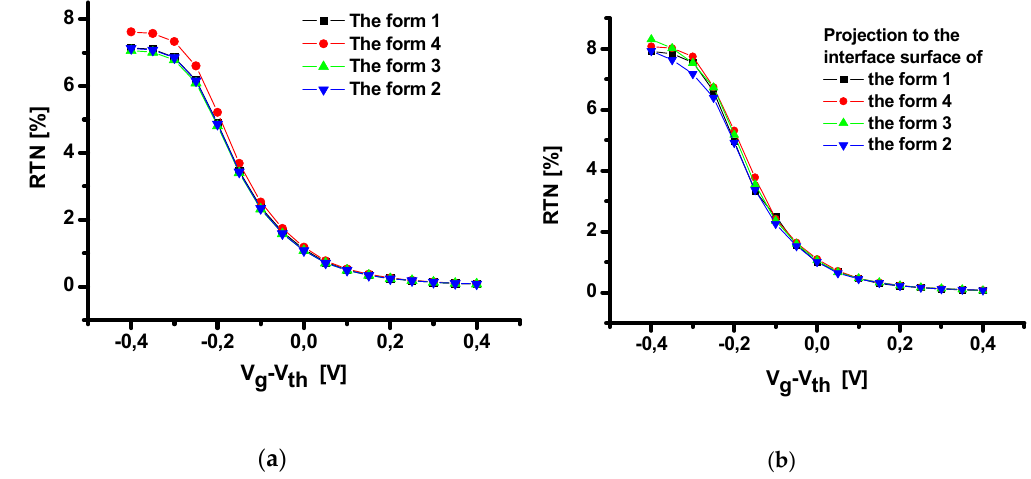
Figure 6. Random telegraph noise (RTN) amplitude dependence on the gate voltage overload generated by single charged defect with different forms: in the oxide layer ( a ) and at the interface ( b ). The RTN amplitude dependence on the radius of spherical or circular area of defects in the oxide or at the interface, correspondingly, was simulated to study the influence of the defect size. One has considered the radius range between 0.1 and 0.5 nm, which covers practically all featured linear sizes of atomic radius and interatomic distances in Si, SiO 2, and HfO 2 . When changing the radius only, the charge density is modified because the trapped charge remains single and elementary The results show that the RTN amplitude depends linearly, but very weakly, on the radius of the defect and practically does not change in the radius range under consideration (see Figure 7). When increasing the radius of the defect area, at a constant trapped charge, the RTN amplitude is practically not changed in all considered ranges of the gate voltage overload. The RTN amplitude in the subthreshold region is not as high as it is reported in some experimental works [14,25]. To find out a possible reason for creating the large RTN amplitudes in the subthreshold region, as observed in our experiments, we have studied the RTN amplitude dependence on single charge quantity in the spherical defect area at the constant radius 0.15 nm. We considered the repeatedly charged defect with constant size. In this case, the RTN is appreciably changed in the subthreshold as well as in the near-threshold region (see Figure 8, 9a). The RTN amplitude in the subthreshold region is considerably increased when increasing the number of single charges N in the defect (see Figure 9b). Obviously, the main reason for creating the high RTN amplitude is not the size as well as the shape of the defects but the density or the number of trapped charges in the defect. 0,1